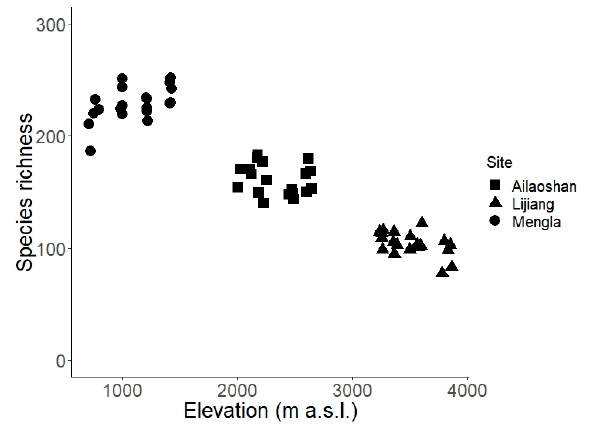
Figure A2. Adjusted moth species richness against elevation (in m a.s.l.) in Mengla, Ailaoshan and Lijiang. Species richness was adjusted based on the smallest sample size. Data from Ashton et al.